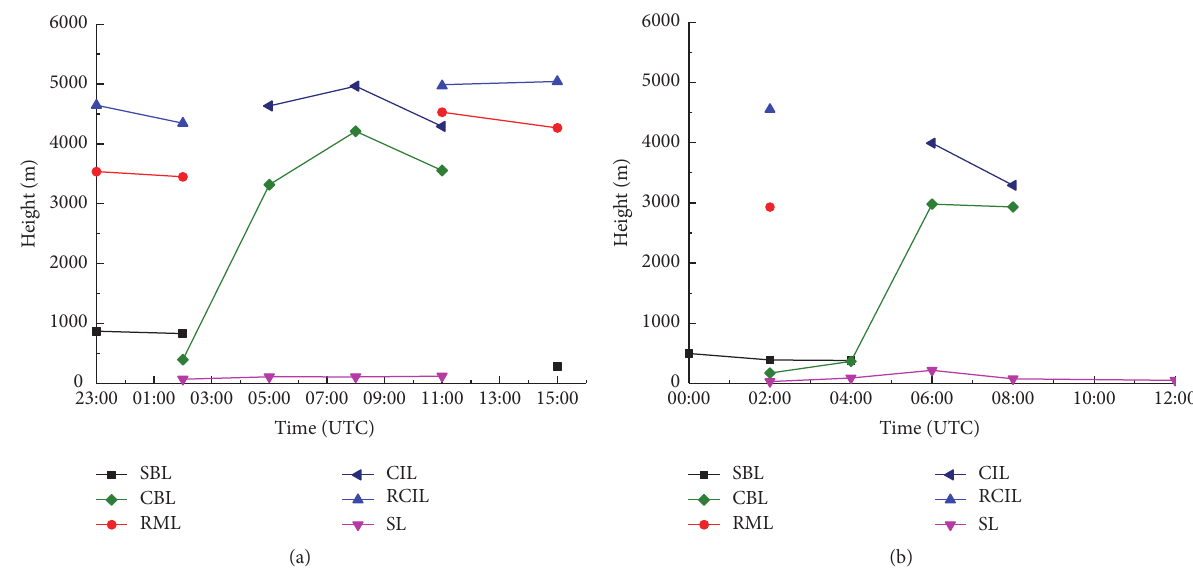
Figure 4: Daily variation of potential temperature structure on (a) July 4, 2012, and (b) August 30,